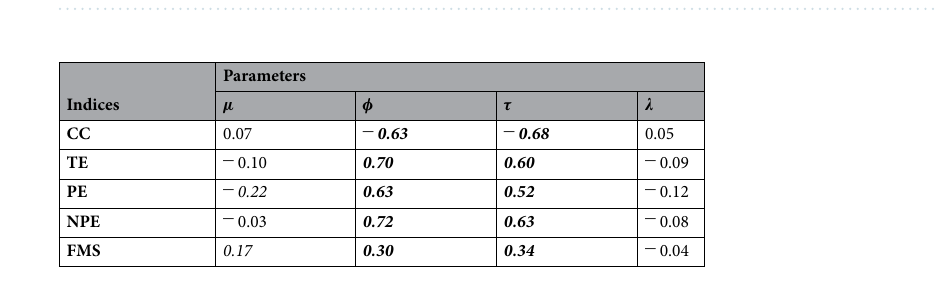
Table 2. Pearson’s correlations between the model key parameters ( µ , φ , τ , (cid:31) ) and WCST indices. The table highlights in bold the correlation indexes with an absolute value above 0.3, and in Italics those that are statistically significant.